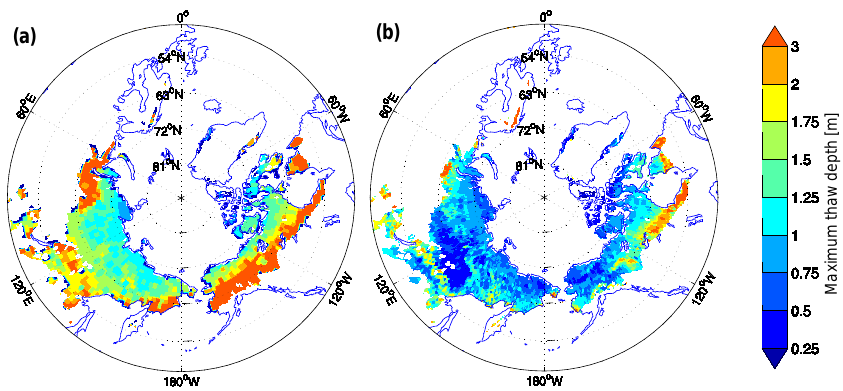
Figure 1. Maximum thaw depth (ALT) averaged over the last 5 years after spin-up from (a) Schaefer et al. (2011) and (b) this study, in